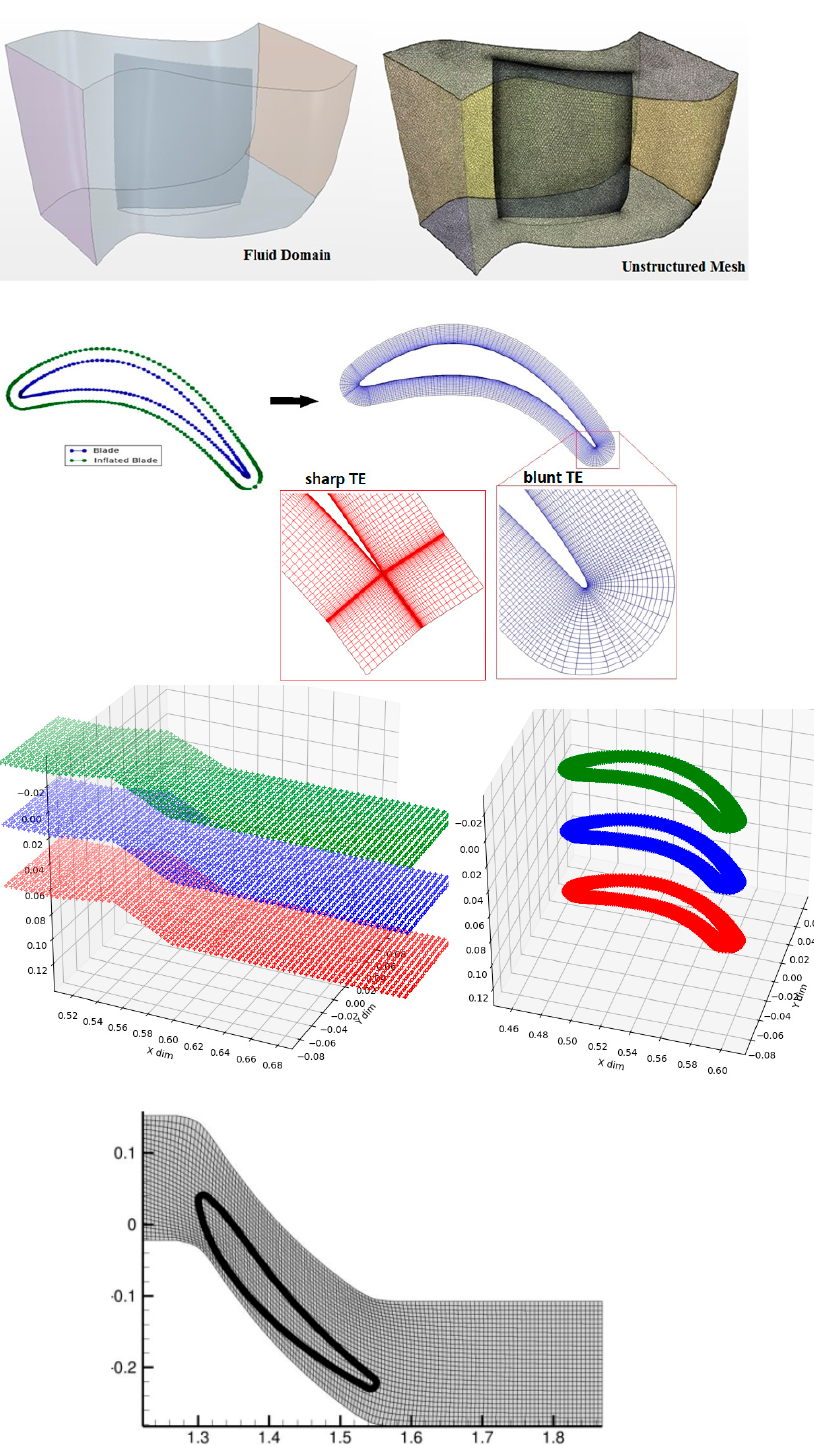
Figure 11. Periodic boundary curves created and imported in a CFD solver for meshing. 2D grids created for round and sharp trailing edge with an elliptic smoother option for overset 2D mesh.